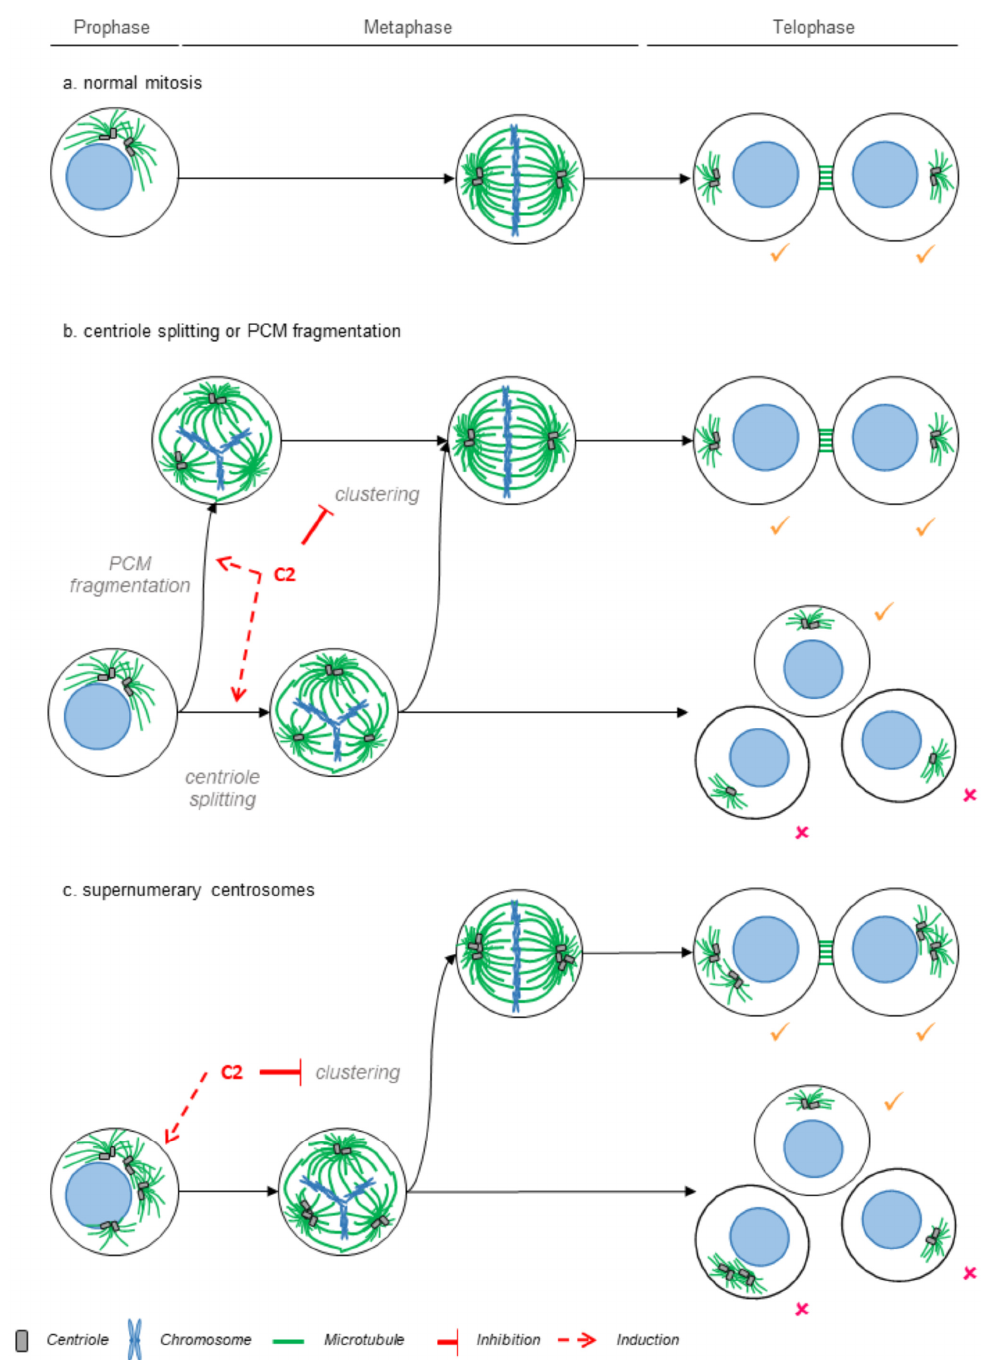
Figure 6. Model for the effects of the C2 combination on cell division. ( a ) Faithful chromosome segregation requires the formation of a bipolar spindle (green) that segregates the genetic material into two daughter cells (normal mitosis). Cancer cells are prone to form multipolar spindles due to fragmentation of the pericentriolar material or premature centriole splitting ( b ) or due to the presence of elevated centrosome numbers ( c ). Since multipolar spindles are often lethal, cancer cells rely on a spindle pole clustering mechanism to form pseudo-bipolar division for survival. Our results are consistent with the hypothesis that the C2 treatment prevents spindle pole clustering and potentially induces multipolar spindle formation, thus increasing the incidence of lethal multipolar cell divisions.